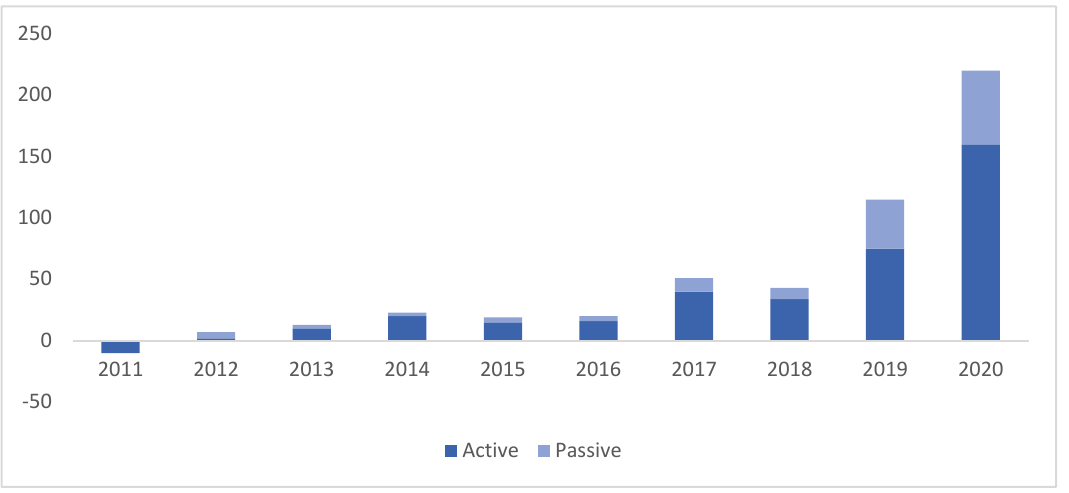
Figure 2. Annual European Sustainable Fund Flows (EUR billion). (Bioy et al. 2020).